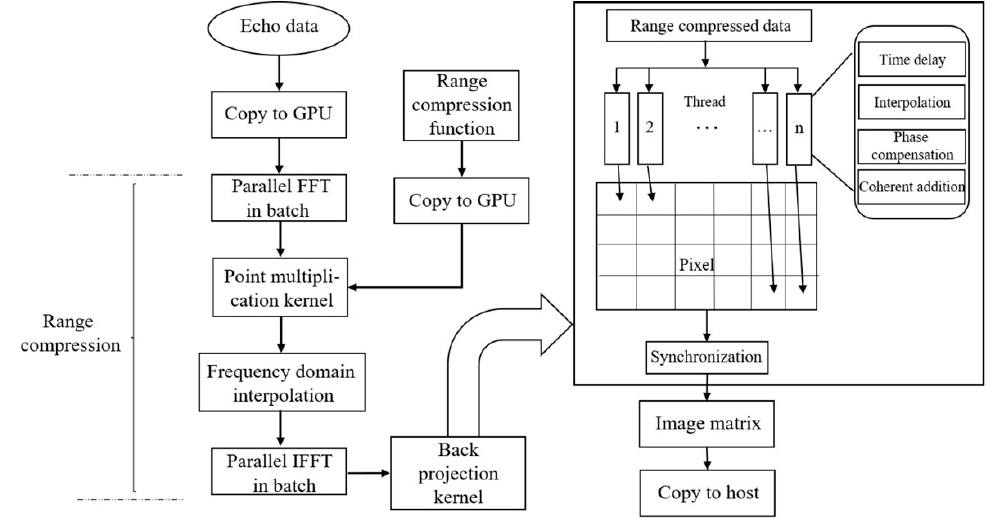
Figure 1. Parallel BP algorithm.